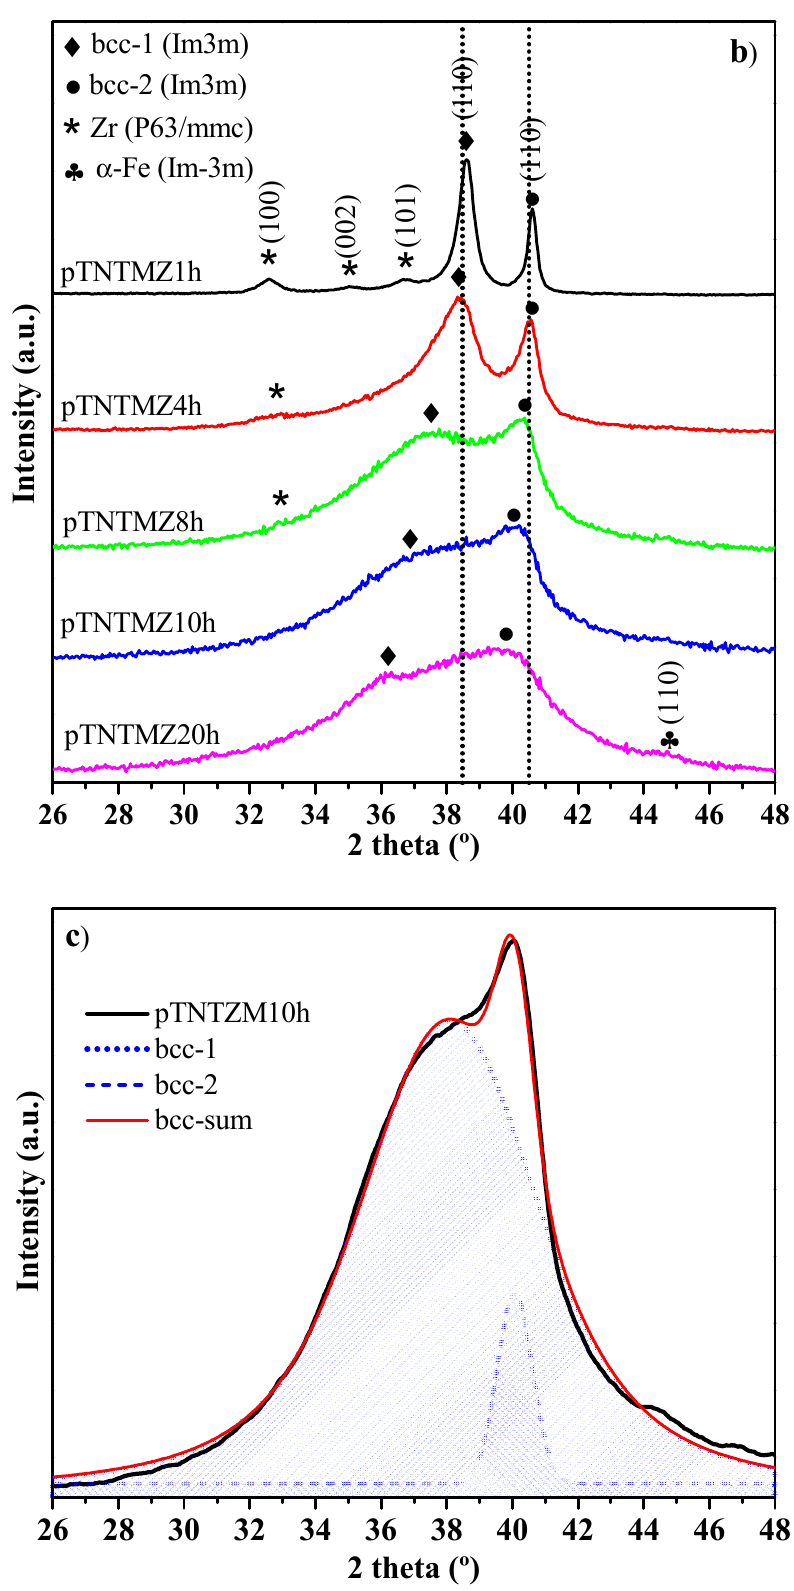
Figure 1. ( a ) XRD patterns showing the pTNTMZ specimens milled between 1 and 20 h. ( b ) Magnification of all XRD patterns and ( c ) fitting for the pTNTMZ10h in the 26–48° 2 θ range and around the (110) crystallographic planes for the both two bcc-1 and bcc-2 alloys. The corresponding crystallographic planes for each phase are marked between brackets. Dotted lines are used to highlight the shift in the XRD peaks.